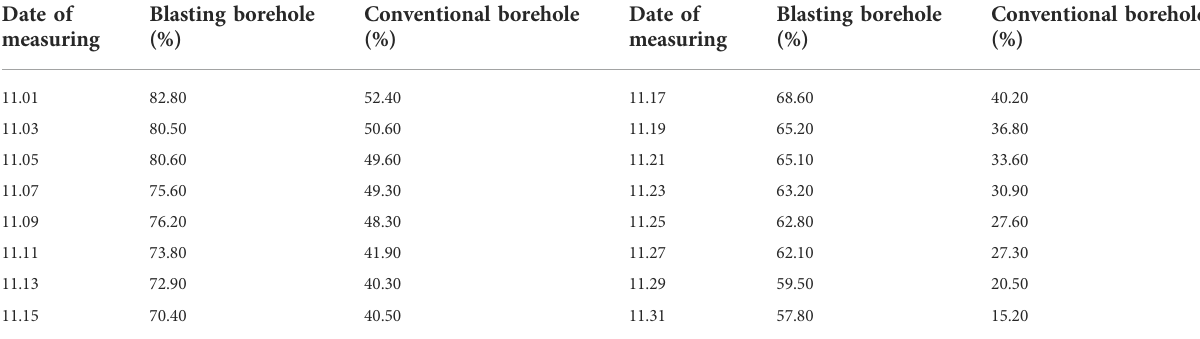
TABLE 5 Gas extraction concentration of blasting boreholes and conventional boreholes.